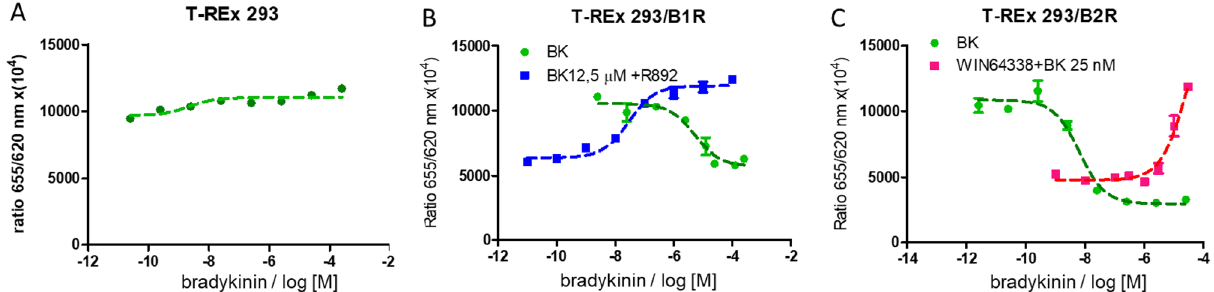
Figure 1. Influence of BK on IP1 levels in the mock T-REx 293 cell line. There is no functional activity of a BK receptor in this cell line because it is not expressed ( A ) and the effect of BK on T-REx 293 cells expressing B1R ( B ) or B2R ( C ). A dose-dependent increase in intracellular IP1 level was observed in presence of BK. In addition, specific antagonist activity for B1R and B2R was examined in the presence of BK, corresponding to EC 80 for each receptor (12.5 µM for B1R and 25 nM for B2R).